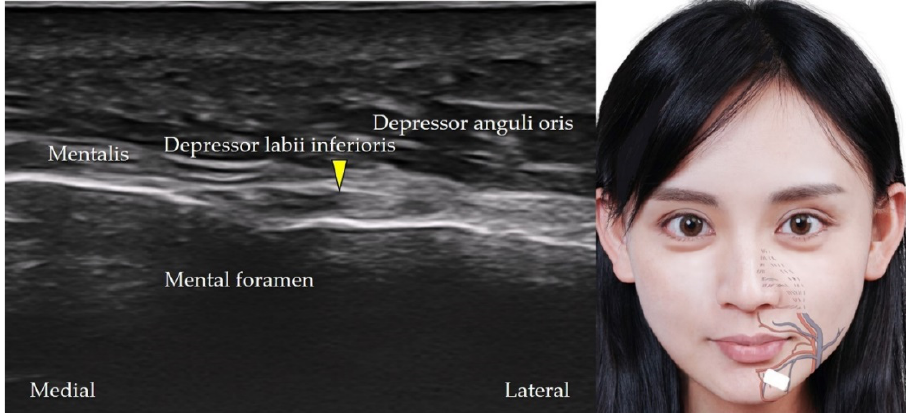
Figure 20. Ultrasound imaging of the mental nerve (yellow arrowhead) . White square , footprint of the ultrasound transducer.